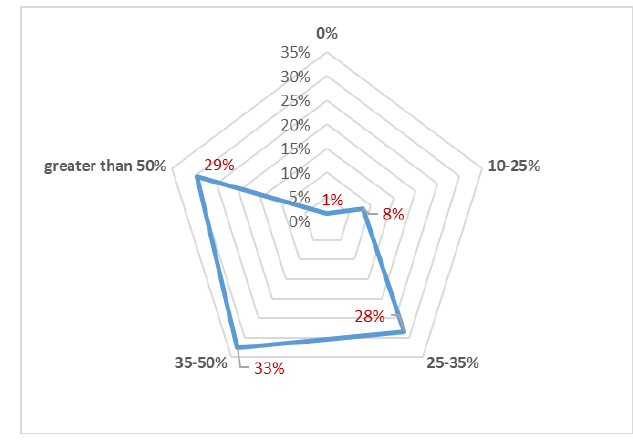
Figure 4: Sample B Investigation during the Covid-19 Spread-Perceptions on CSR